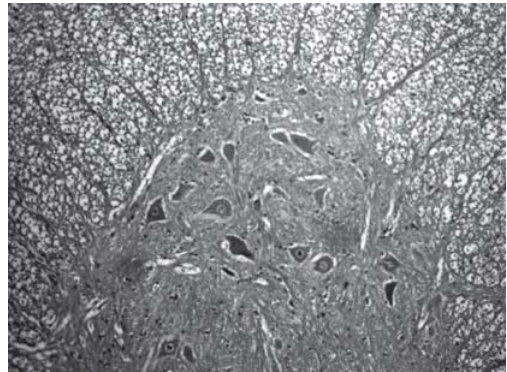
Fig. 6 - Animals with grade III injury (complete widespread neuronal necrosis)